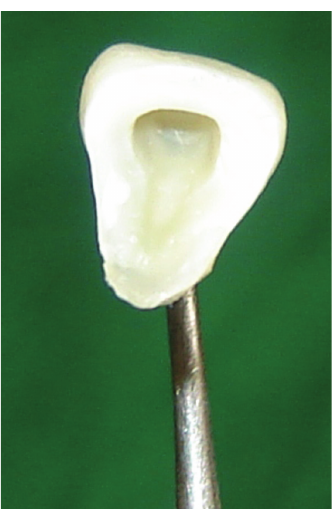
Figure 5: Groove prepared in the fractured fragment.